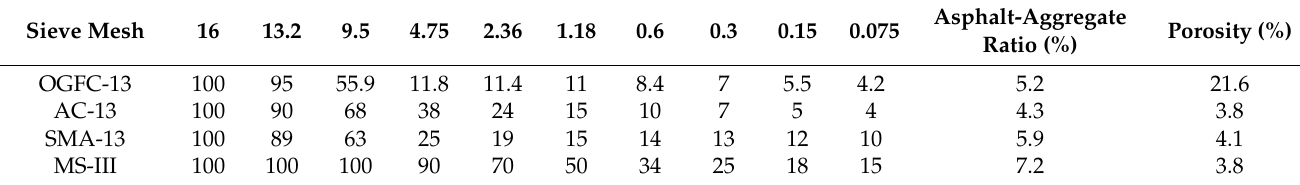
Table 6. The mixture design index.